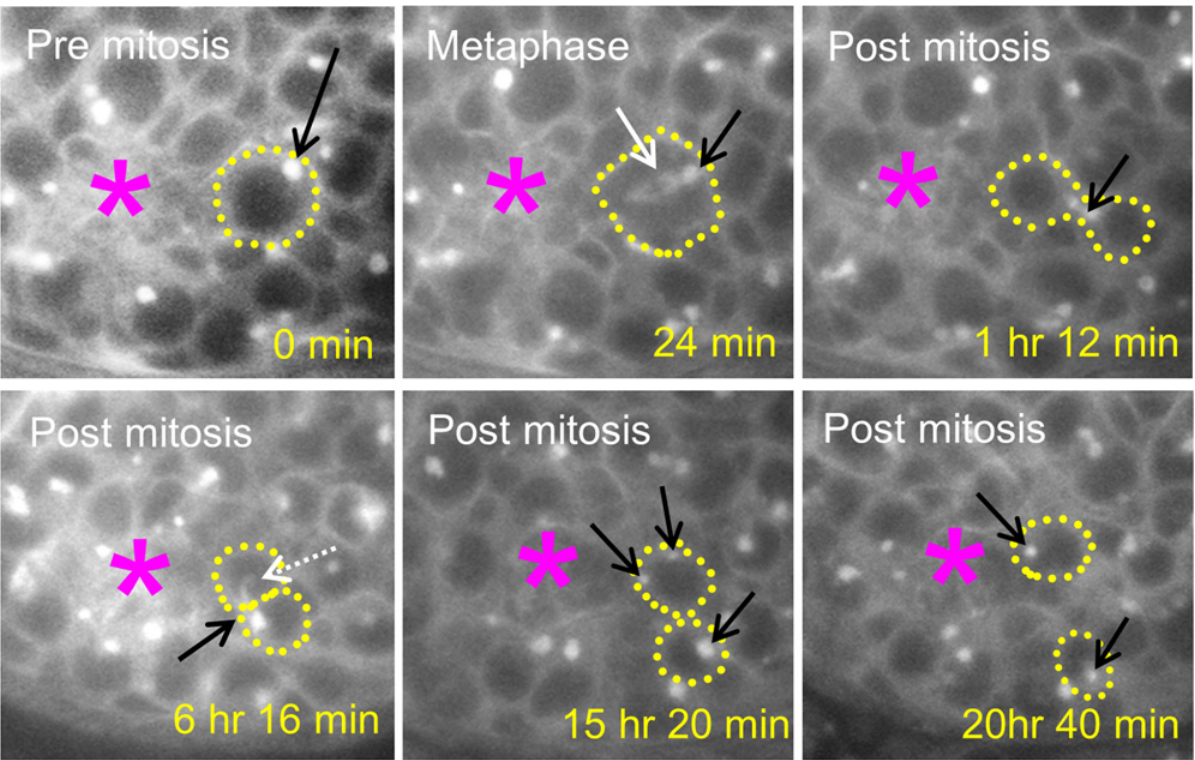
Fig 3. Spectrosome material is transferred via ring canal in GSCs. Spectrosome (Short Adducin-GFP) in wild type GSC is located in the basal position (0 min: interphase and 24min: metaphase). At 1hr 12min, spectrosome is co-localized with the ring canal structure. Spectrosome, together with ring canal structure, grows into the stem cell daughter at 6hr 16min, segregates into both daughter cells and form spectrosome-like structure again at 15hr 20 min. At 20hr 40 min, spectrosomes in both GSC and gonialblast further develop, and the gonialblast separates from GSC. Cellular boundaries and mitotic spindle are visualized with α -tub-GFP. Black arrow: spectrosome. White dash-arrow: spectrosome and/or ring canal tail. * : hub cells. Yellow dash-line: GSC or gonialblast boundary. Solid white arrow: mitotic spindle.